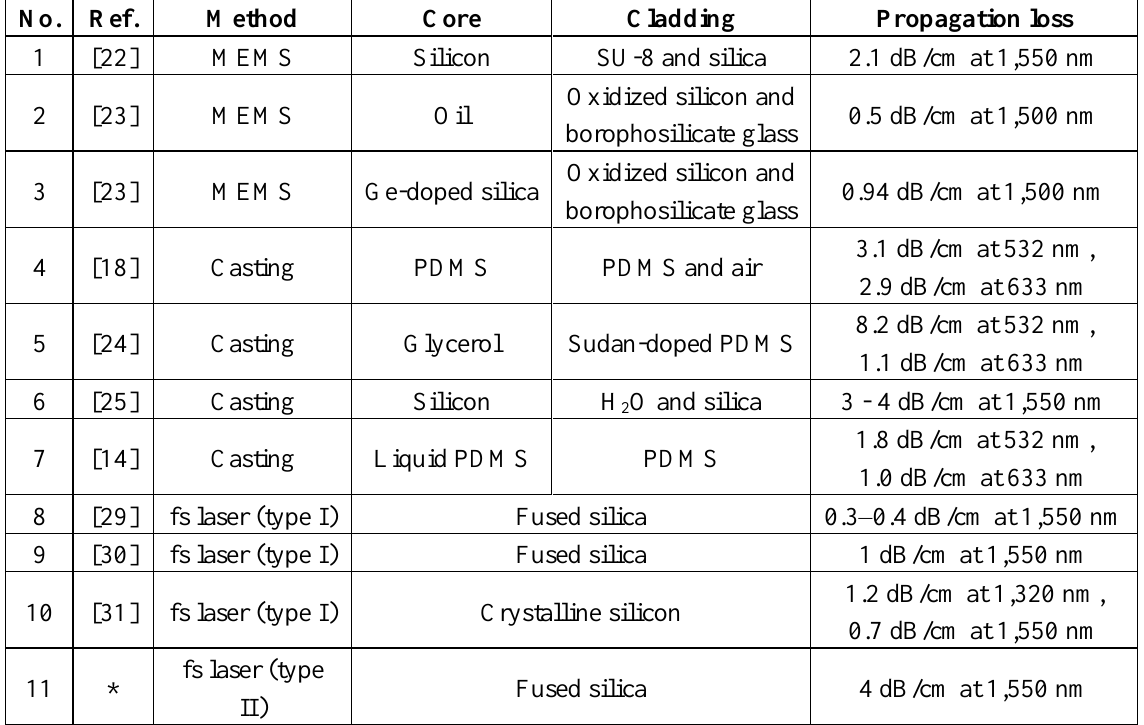
Table 3. Comparison of the properties of optofluidic waveguides fabricated by different techniques. No.